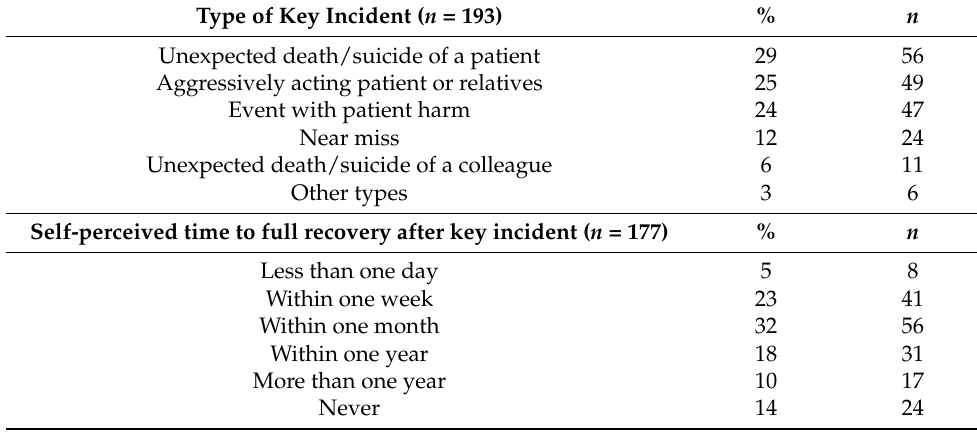
Table 3. Type of key events and time to self-perceived full recovery among second